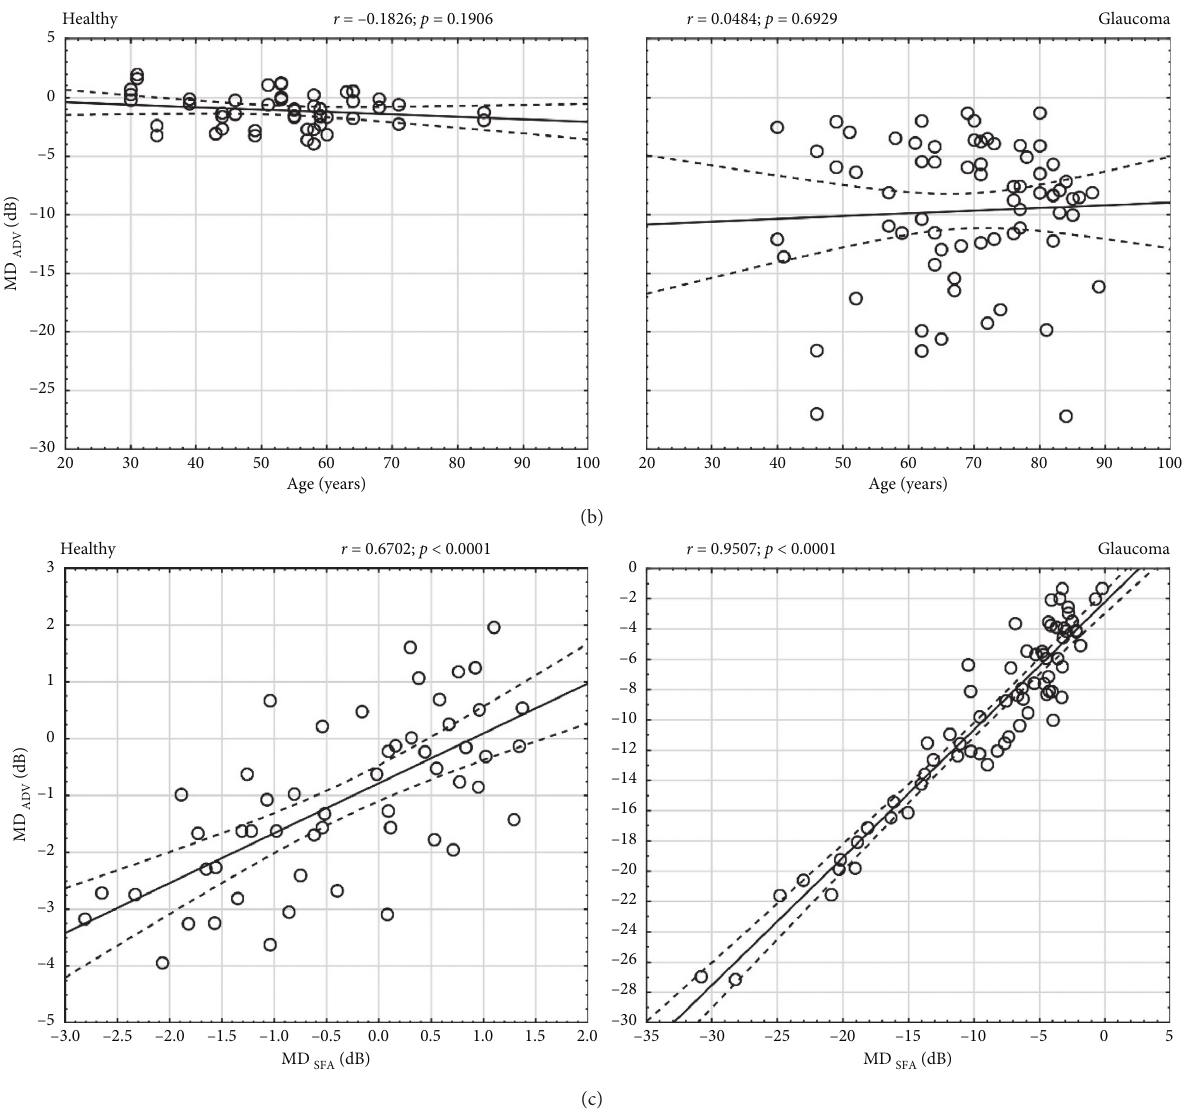
Figure 7: The analysis of mean deviation in healthy and glaucomatous eyes. (a, b) Correlation of SFA MD and ADV MD with patient age; (c) correlation between MD for ADV and MD for the SFA